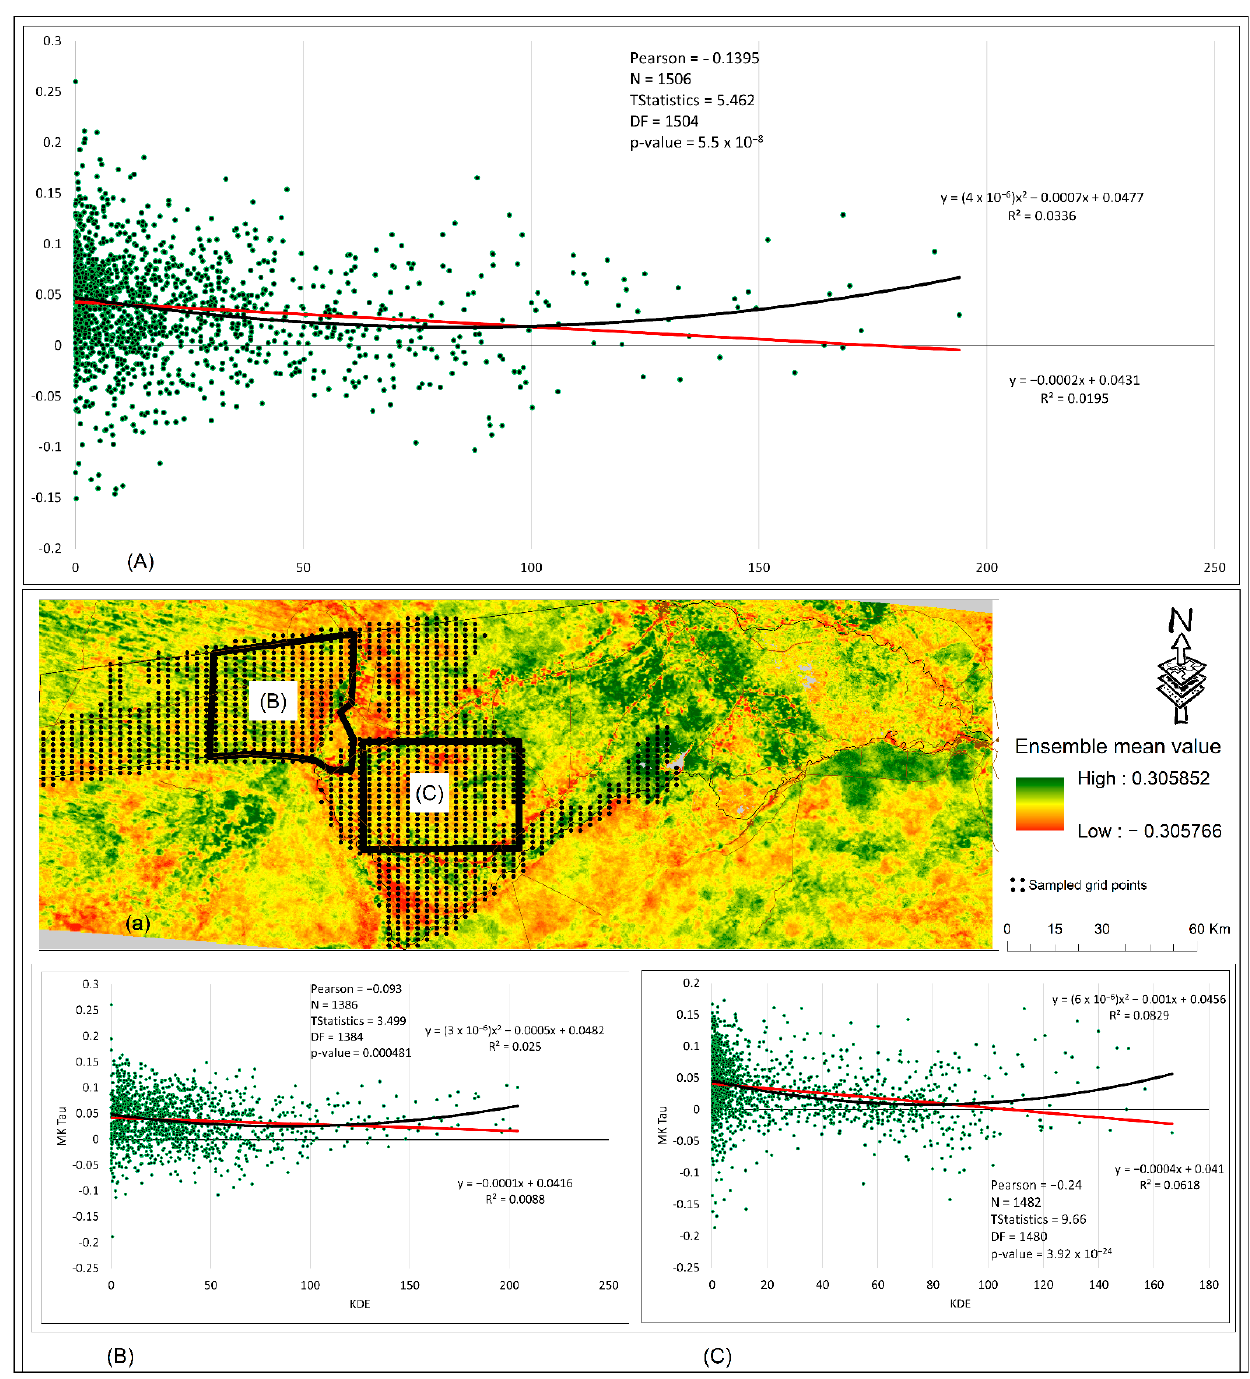
Figure 3. Shows the locations of the sampled grid points in the Zambezi region of the Kernel Density Estimate and the ensemble. The grid points are overlayed on the ensemble (a) used previously in Figure 2. The results of the Pearson correlation in ( A ) correspond to all the sampled points in the Zambezi while ( B ), and ( C ) correspond to the sub-sampled areas (black polygons) above.